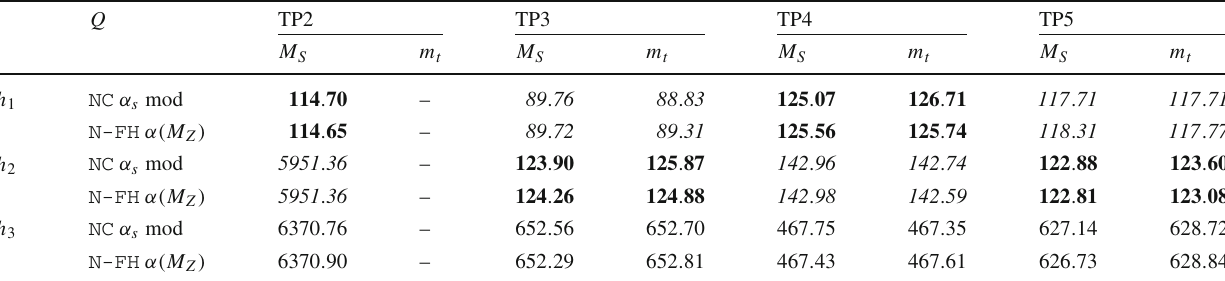
Table 8 Mass predictions for the CP -even scalars for TP2–TP5 when is used. The values correspond to the two-loop result obtained with the OS renormalization scheme for the top/stop sectors. The mass values using modified versions of NMSSMCALC in the OS option NC OS for the SM-like scalar are written in bold fonts, those for the singlet-like (denoted shortly by NC ) and NMSSM-FeynHiggs ( N-FH ). Both scalar in italics codes are modified to use an identical numerical value for α s . In NMSSM-FeynHiggs the reparametrization to α( M Z ) ( N-FH α( M Z ) ) Q TP2 TP3